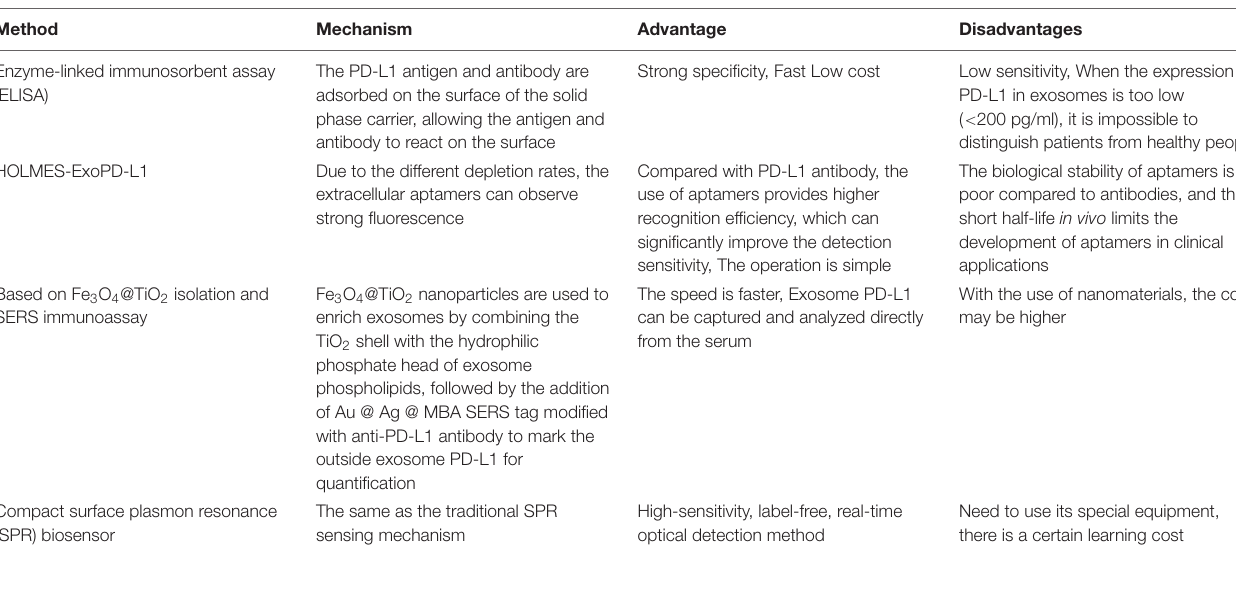
TABLE 2 | Exosome PD-L1 detection